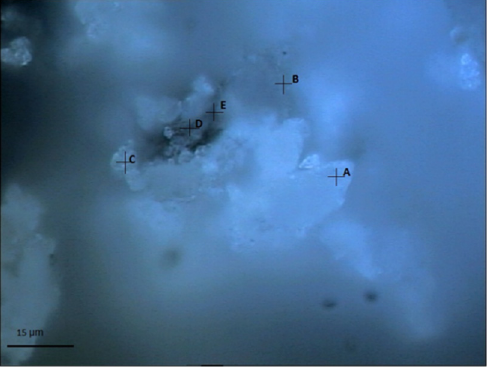
Figure 1. Light optical micrograph showing the selected testing area and points (A–E) in the carbonated SF–PC sample.